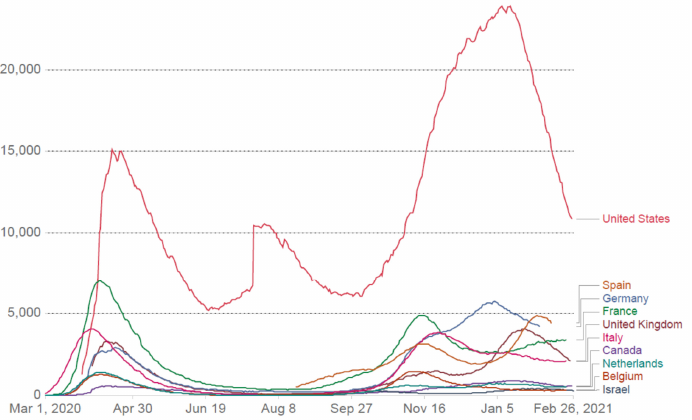
Figure 2. Number of COVID-19 patients in intensive care unit (ICU) in the United States, Spain, Germany, France, United Kingdom, Italy, Canada, the Netherlands, Belgium and Israel from